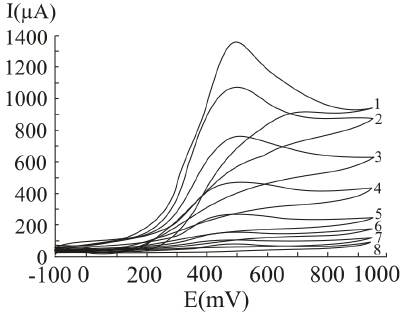
Figure 6. Calibration graph obtained at ascorbic acid determination by cyclic voltammetry at a Pt working electrode; for experimental conditions see Figure